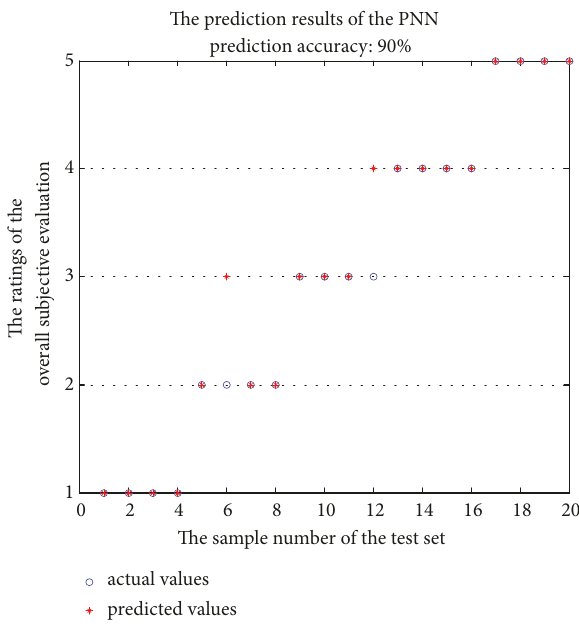
Figure 7: Prediction results of the overall subjective